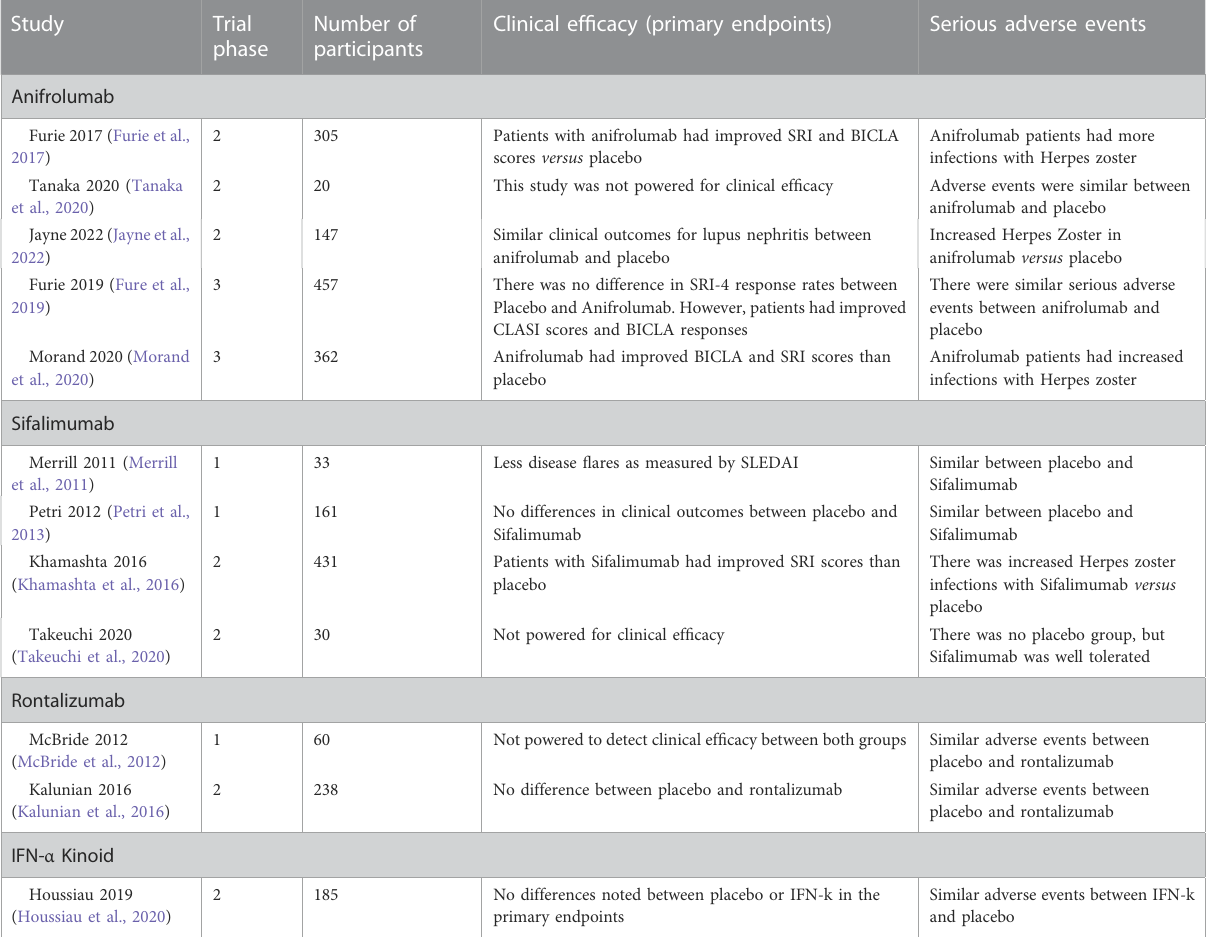
TABLE 2 Randomized Controlled Clinical Trials of anti-interferon